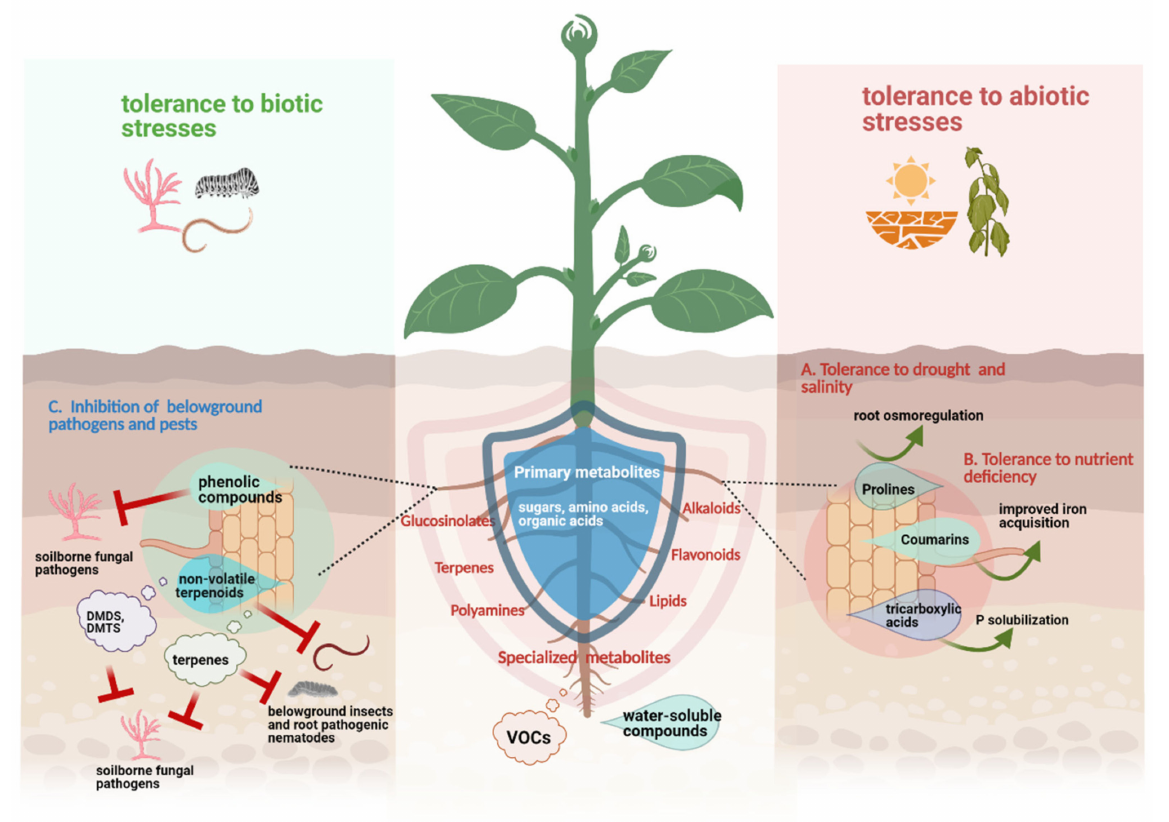
Figure 1. Schematic representation of the direct role of root exudates in plant resistance against biotic and abiotic stresses; drought and salinity (A), nutrient deficiency (B), and belowground pathogens and pests (C). Some specialized metabolites such as prolines, coumarins and organic acids can promote plant growth under abiotic stress conditions (i.e., drought, salinity, and nutrient deficiency) either via improved nutrient/mineral acquisition or active root osmoregulation. Meanwhile, upon a particular biotic stress, specialized root exudates such as phenolic compounds, non-volatile terpenoids, volatile terpenes and sulfurous compounds (i.e., dimethyl disulfide (DMDS), dimethyl trisulfide (DMTS)) are released and can directly inhibit the growth of invading soil-borne pathogens and pests. This figure was designed with Biorender (https://www.biorender.com, accessed on 18 April